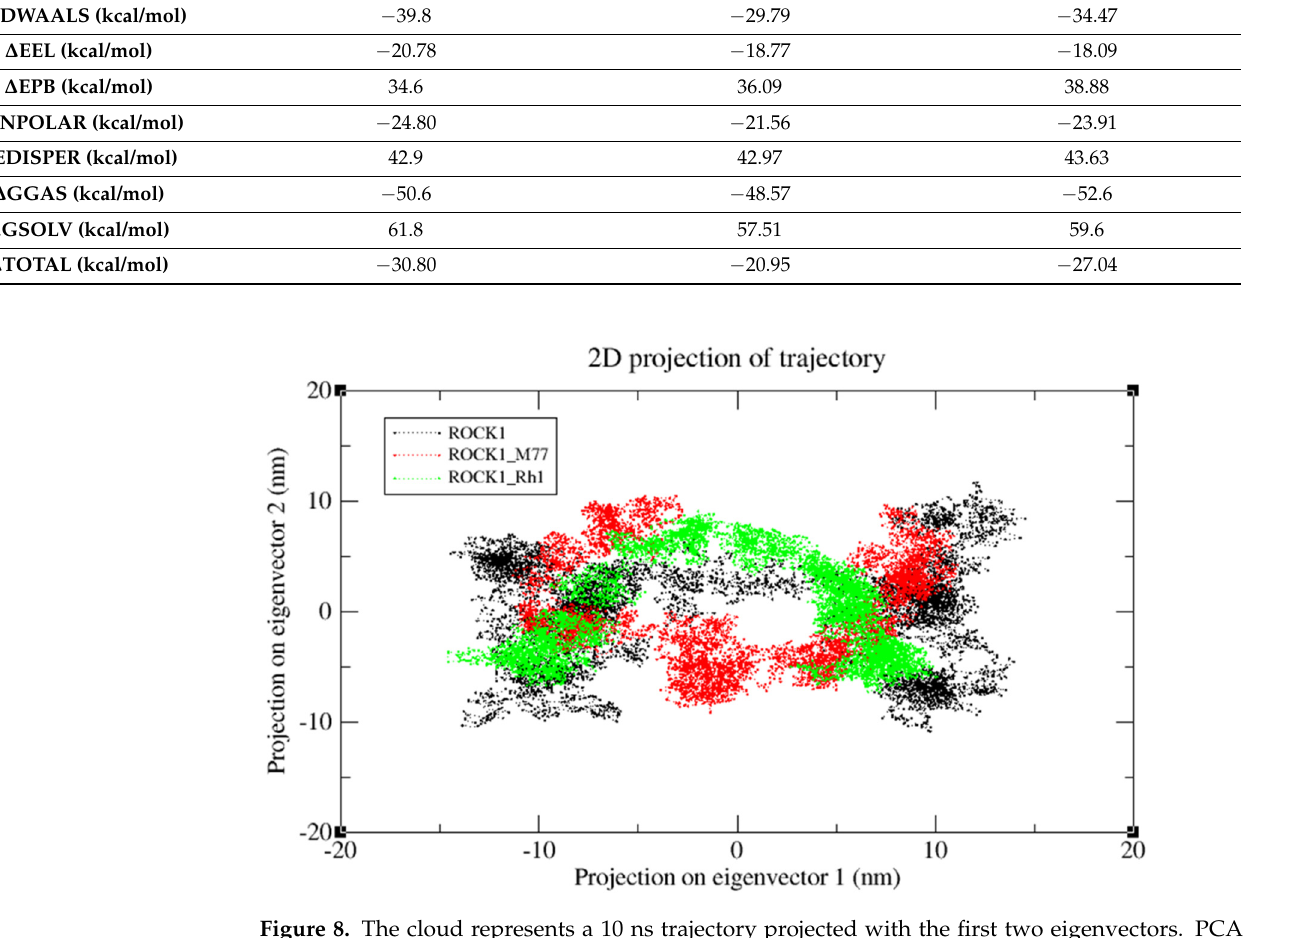
Figure 8. The cloud represents a 10 ns trajectory projected with the first two eigenvectors. PCA re- sults of ROCK1 protein, ROCK1-fasudil, and ROCK1-ginsenosde Rh1 trajectories are shown in black, red, and green, respectively.